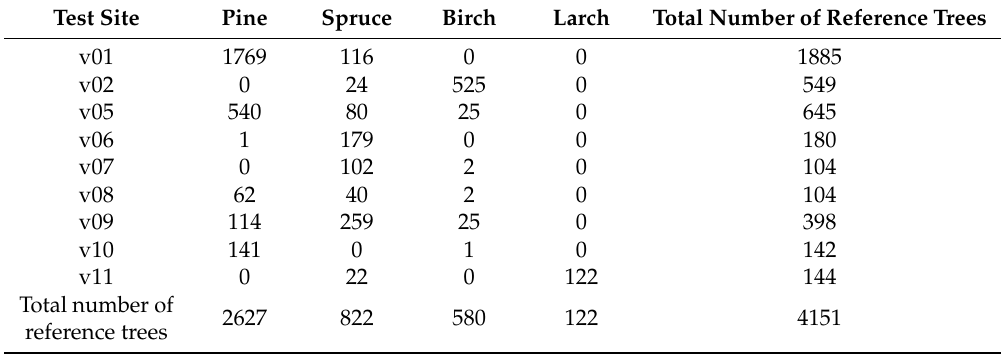
Table 9. The final reference tree data. Reference data for the test site v0304 could not be aligned properly, and thus it was omitted from the